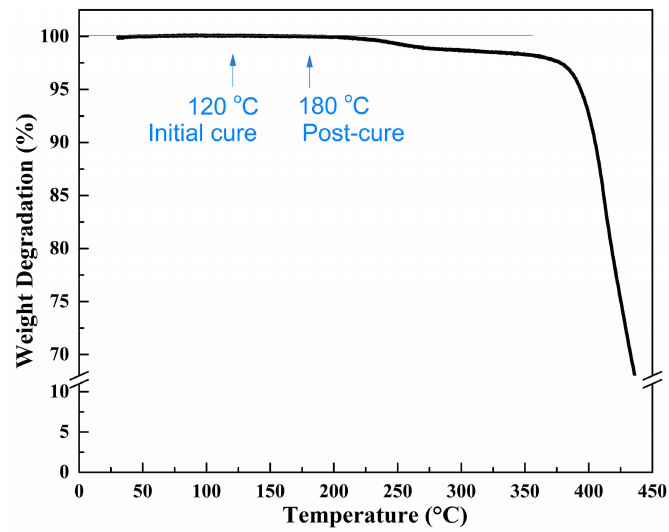
Figure 2. Thermogravimetric curve of the